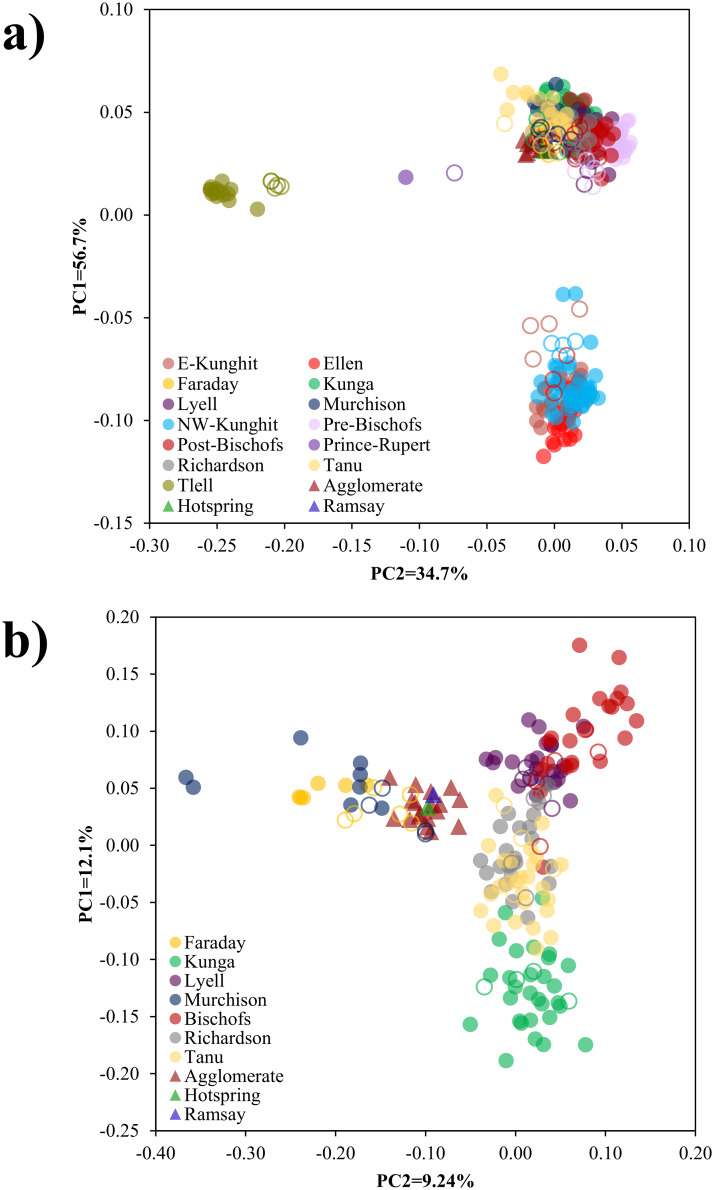
(a) Principle component analysis (PCA) for brown rats (Rattus norvegicus, n = 338) collected throughout Haida Gwaii, BC. Eigenvectors were inferred using ddRAD samples (filled circles; n = 265), with GT-seq samples (hollow circles, triangles; n = 73) posteriorly projected onto inferred eigenvectors. All analyses were performed using the same 315 loci, and analysis was implemented using EIGENSOFT v7.2.1 [49–51]. PCA was re-run using only populations centrally-located in Haida Gwaii (b) for assignment of individuals from novel island invasions (triangles, n = 20).